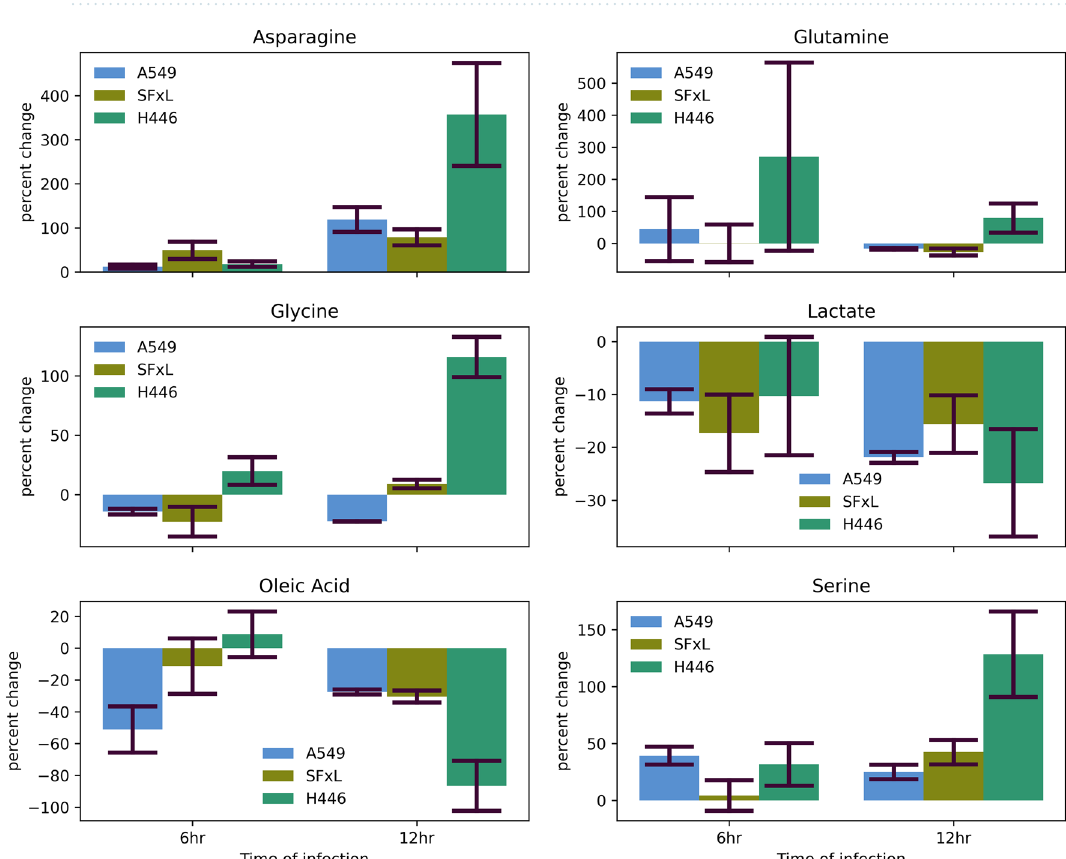
Figure 6. Metabolic signatures between control and infected cancer cells: Percent change in metabolite levels between control and MYXV-infected cells at 6 h and 12 h post infection. Percent change calculated as change from control to infected. Only those metabolites that were identified as statistically significant by Student’s t-test (p < 0.05) across all three cells (A549, SFxL, H446: N = 3) are shown